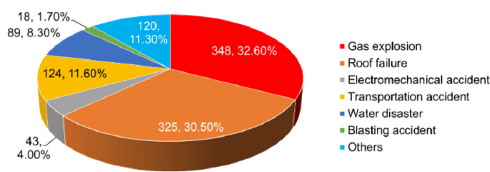
Figure 3. Proportional distribution of deaths induced by coal disasters in 2013.